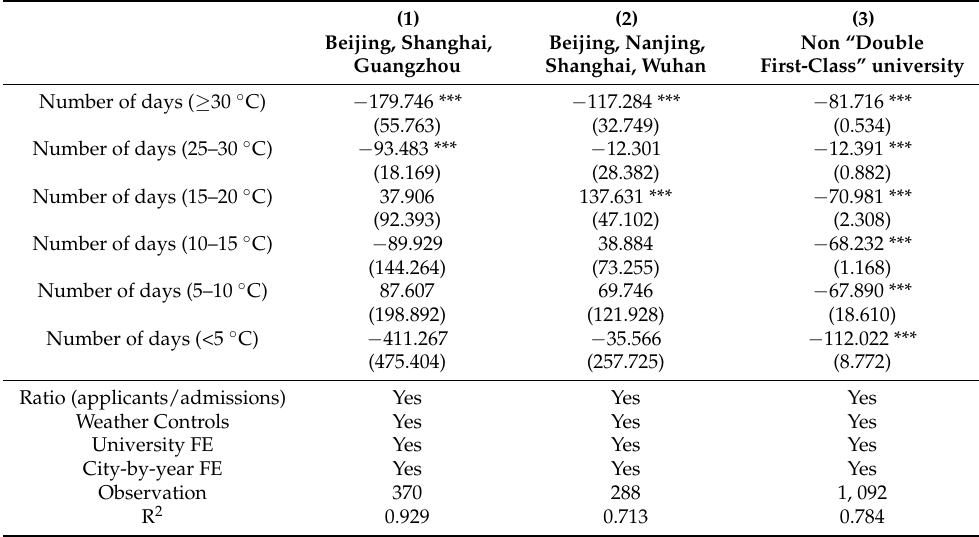
Table 8. Robustness checks: alternative